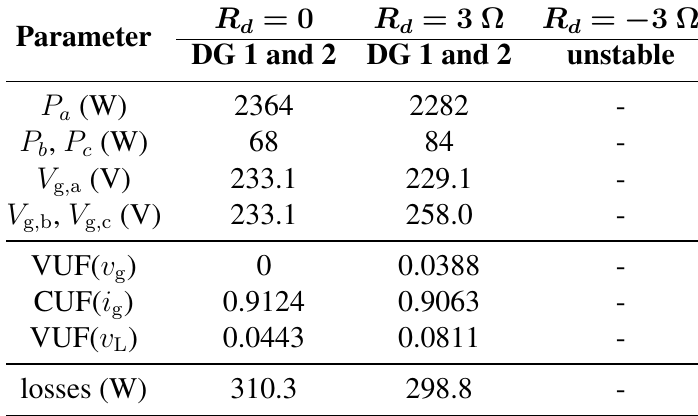
Table 6. Islanded microgrid with two DG units: CM versus RU versus the CW variant = 3 Ω ; R = 0 Ω ( R l v